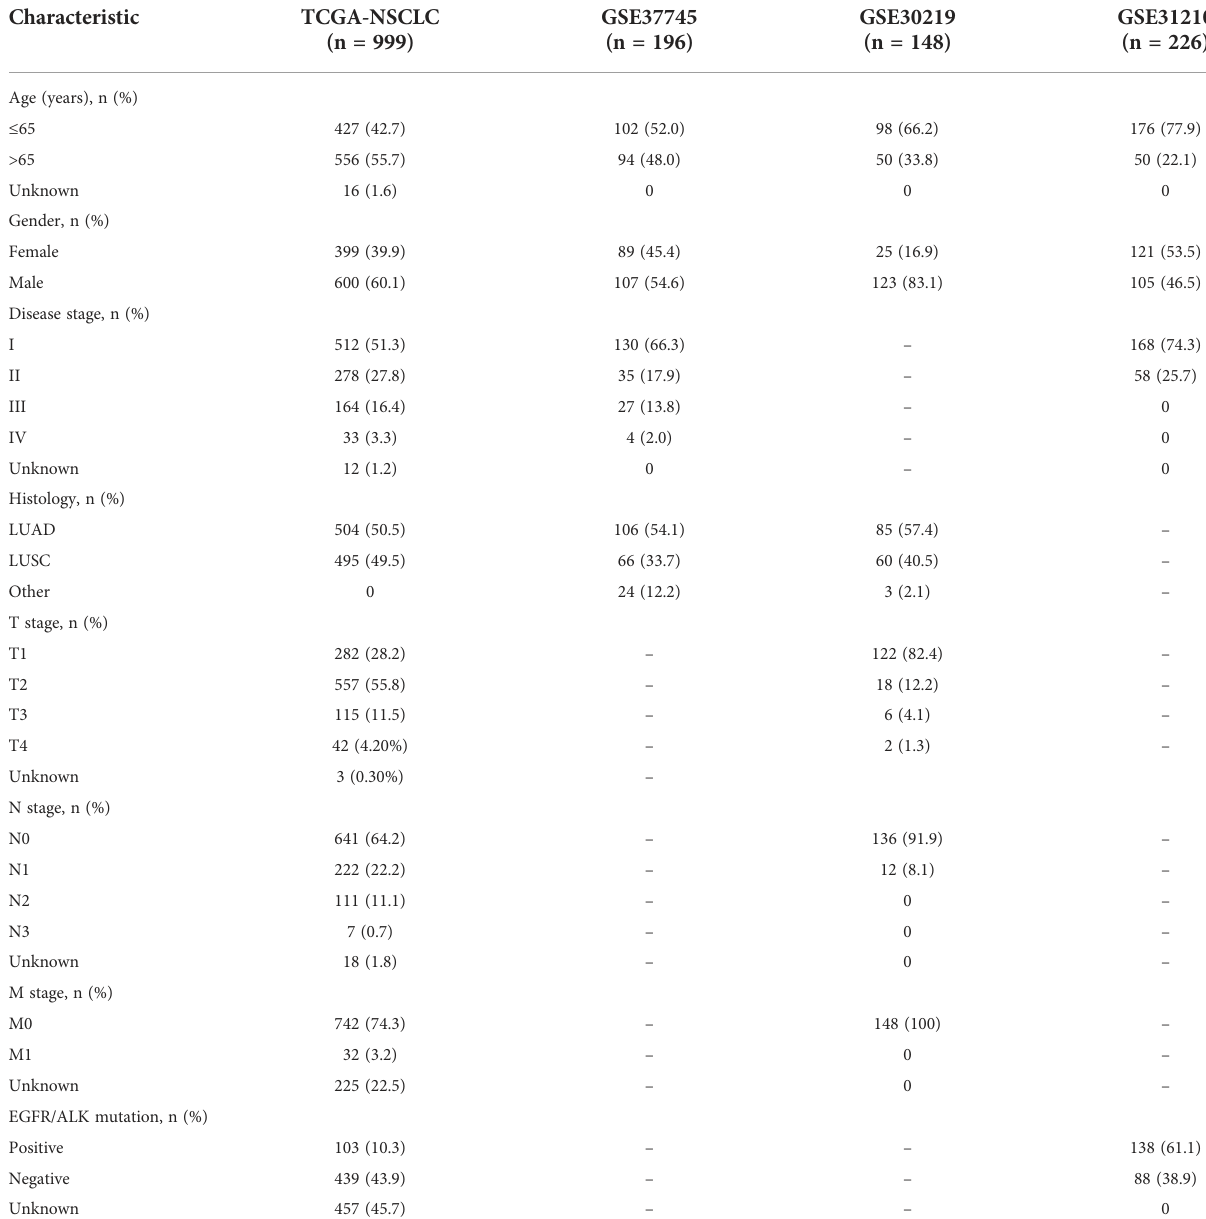
TABLE 1 Basic characteristics of the NSCLC patients from TCGA and GEO